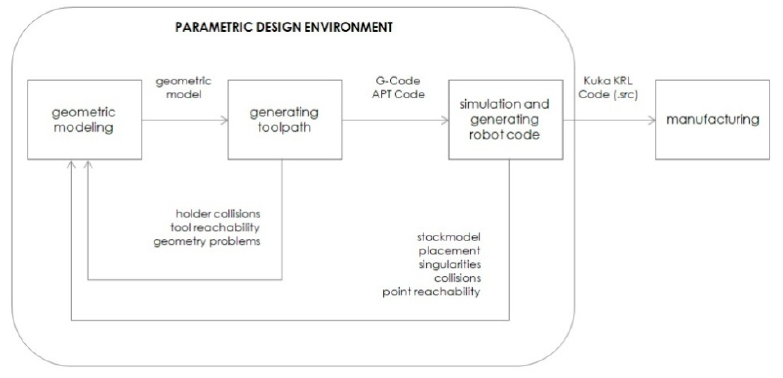
Figure 1. Robotic fabrication workflow in the parametric-design environment [23].